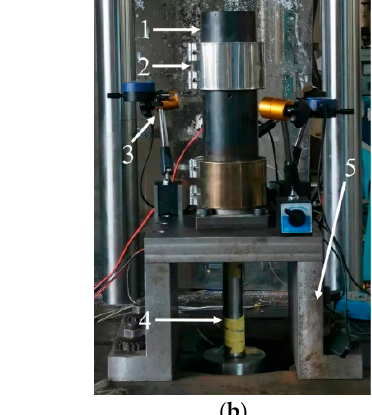
Figure 2. Squeeze casting machine ( a ) picture and ( b ) structure. Note: 1—punch; 2—shot sleeve; 3—pushing rod; 4—pushing cylinder; 5—horizontal displacement cylinder.